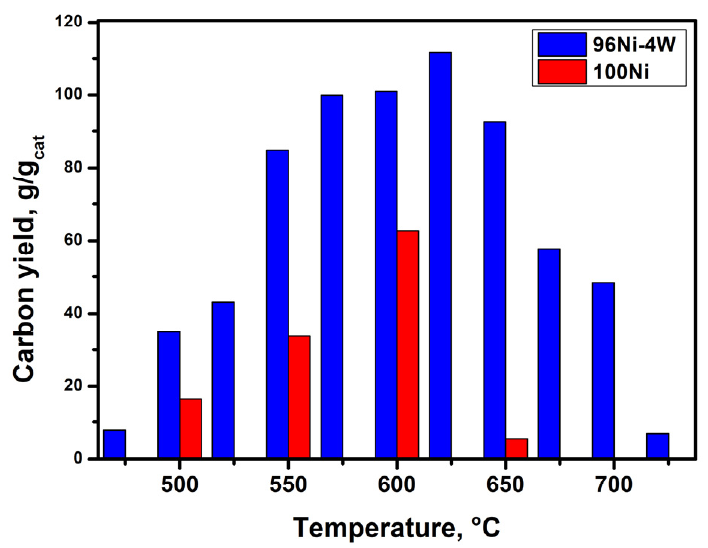
Figure 7. Dependence of the CNF yield on the temperature for 100Ni and 96Ni-4W catalysts tested in the reaction of catalytic decomposition of TCE in an excess of H 2 .